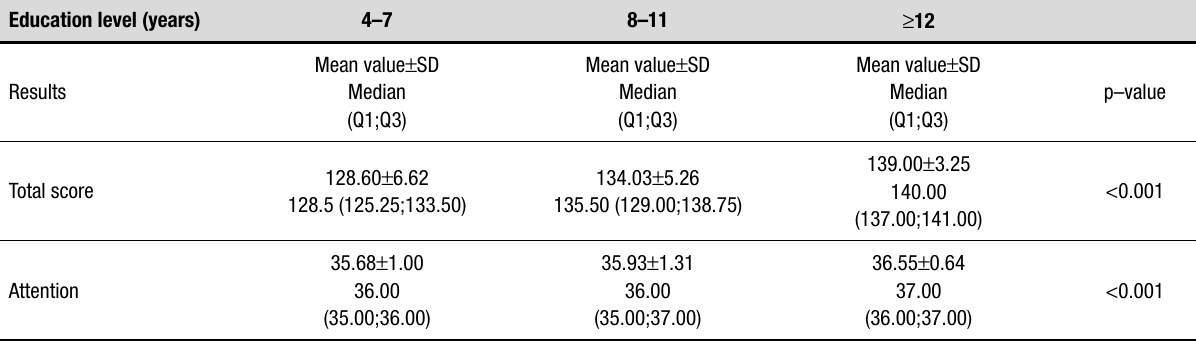
Table 4. Comparisons between groups according to education level in the Mattis Dementia Rating